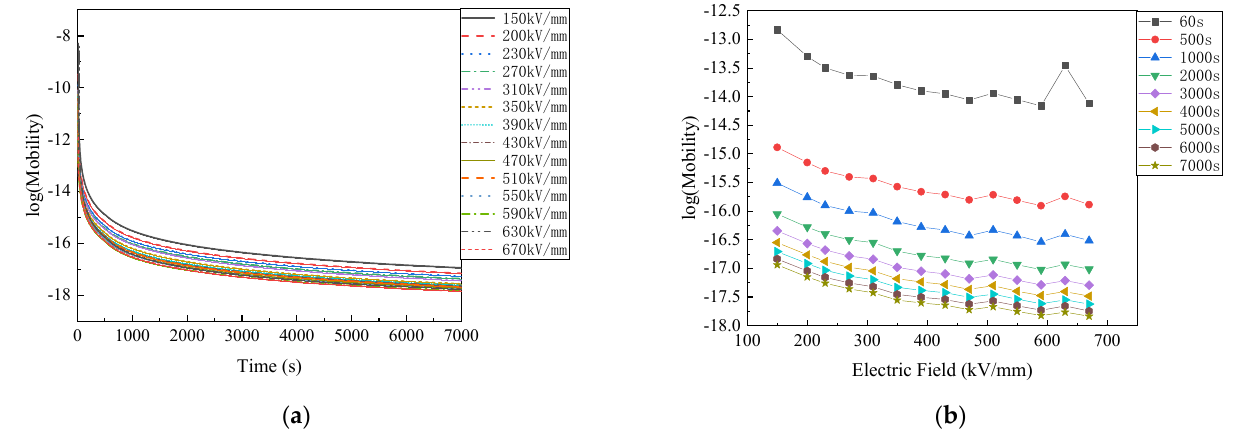
Figure 5. The carrier mobility of biaxial polypropylene films at 20 °C. (( a ): The carrier mobility versus time; ( b ): The carrier mobility versus electric field).